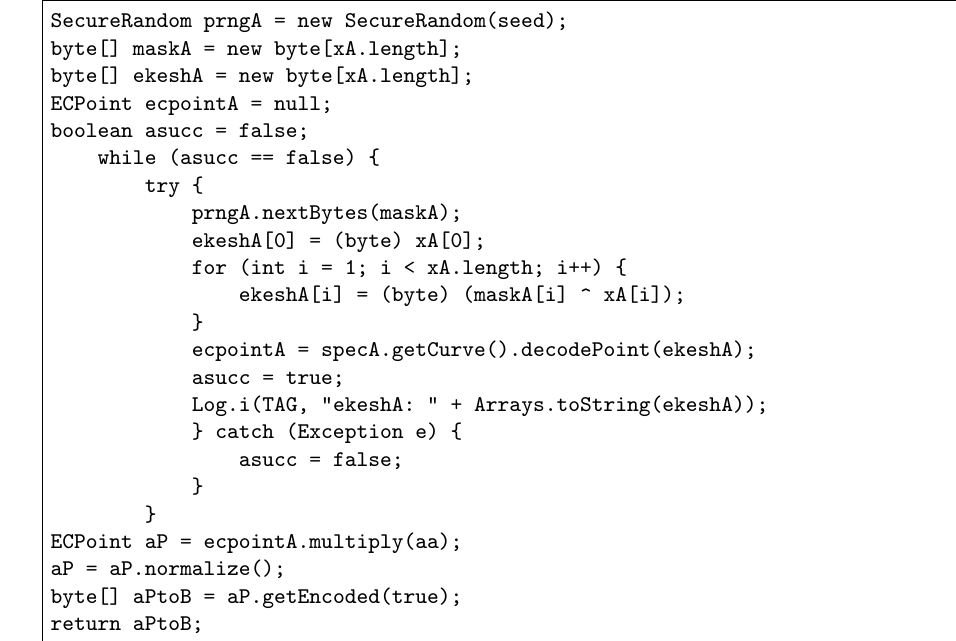
Figure 9. Code snippet for the SPEKE protocol implementation in Java.